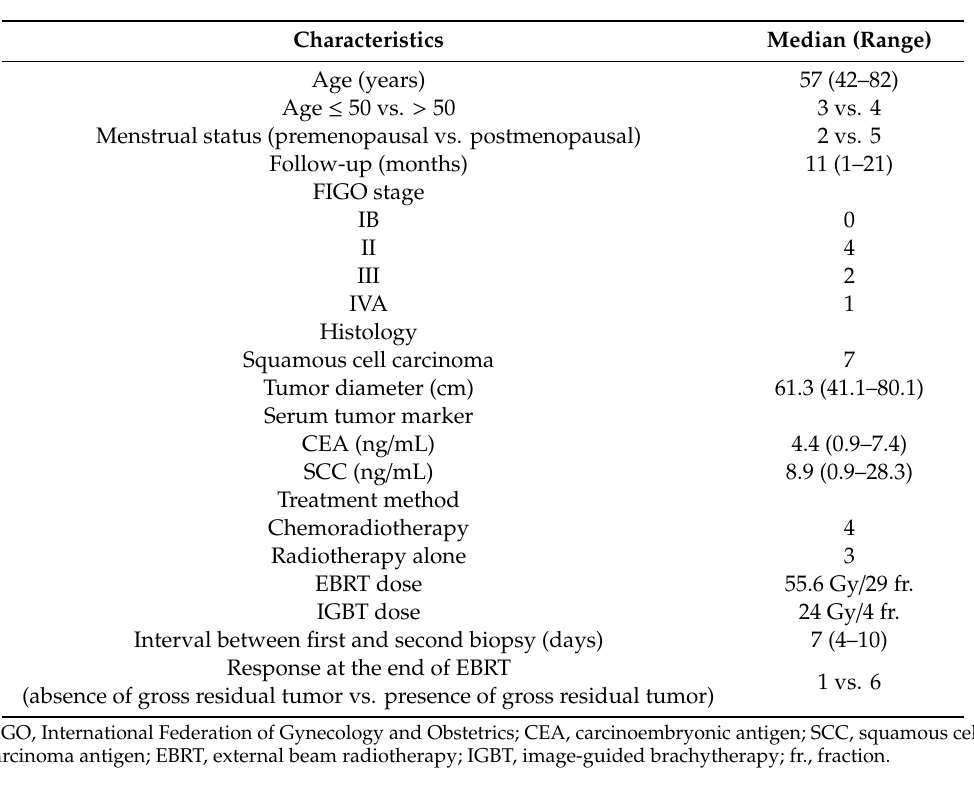
Table 1. Patient characteristics.